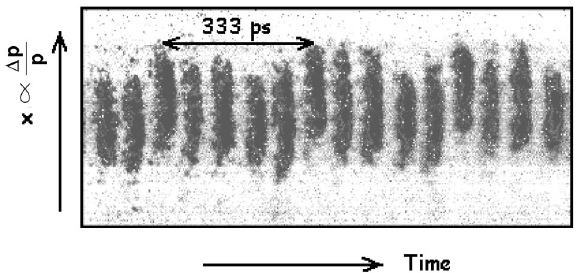
FIG. 23. Streak camera image of a combined beam (factor 5), showing bunch-to-bunch variations in transverse position. The dispersion function at the observation point is j D periodicity corresponding to the combination factor is clearly visible.